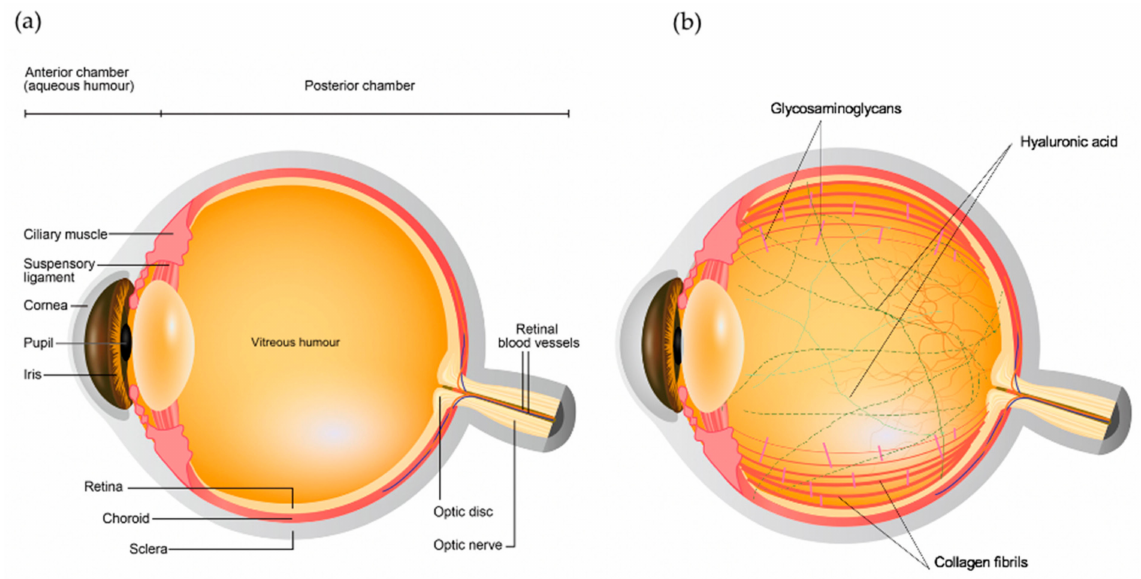
Figure 1. Schematic diagram of the ( a ) ocular structures and ( b ) vitreous